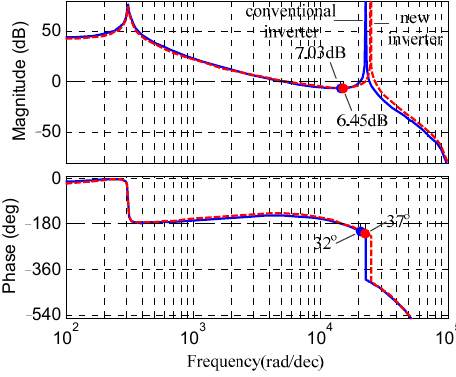
Figure 11. Bode diagrams of G os for new and conventional inverters.